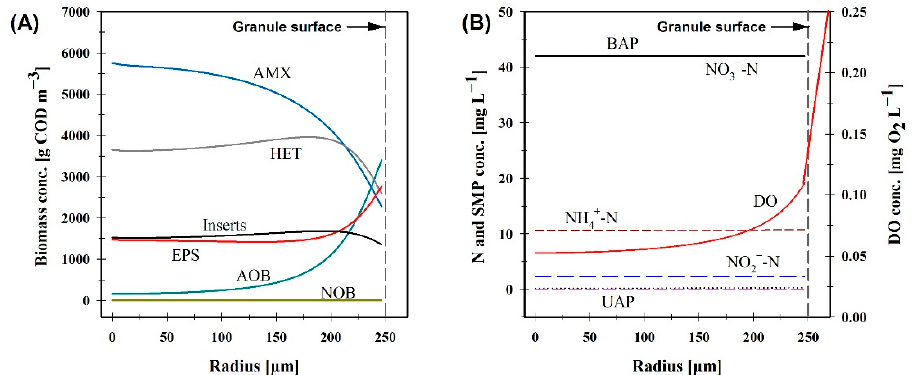
Figure 5. Spatial distribution of ( A ) biomass concentrations and ( B ) solute concentrations along the radius of the granules in the standard case (granule diameter 0.5 mm, DO 0.25 mg L − 1 , influent ammonium 500 mg N L − 1 ) revealed by model analysis.